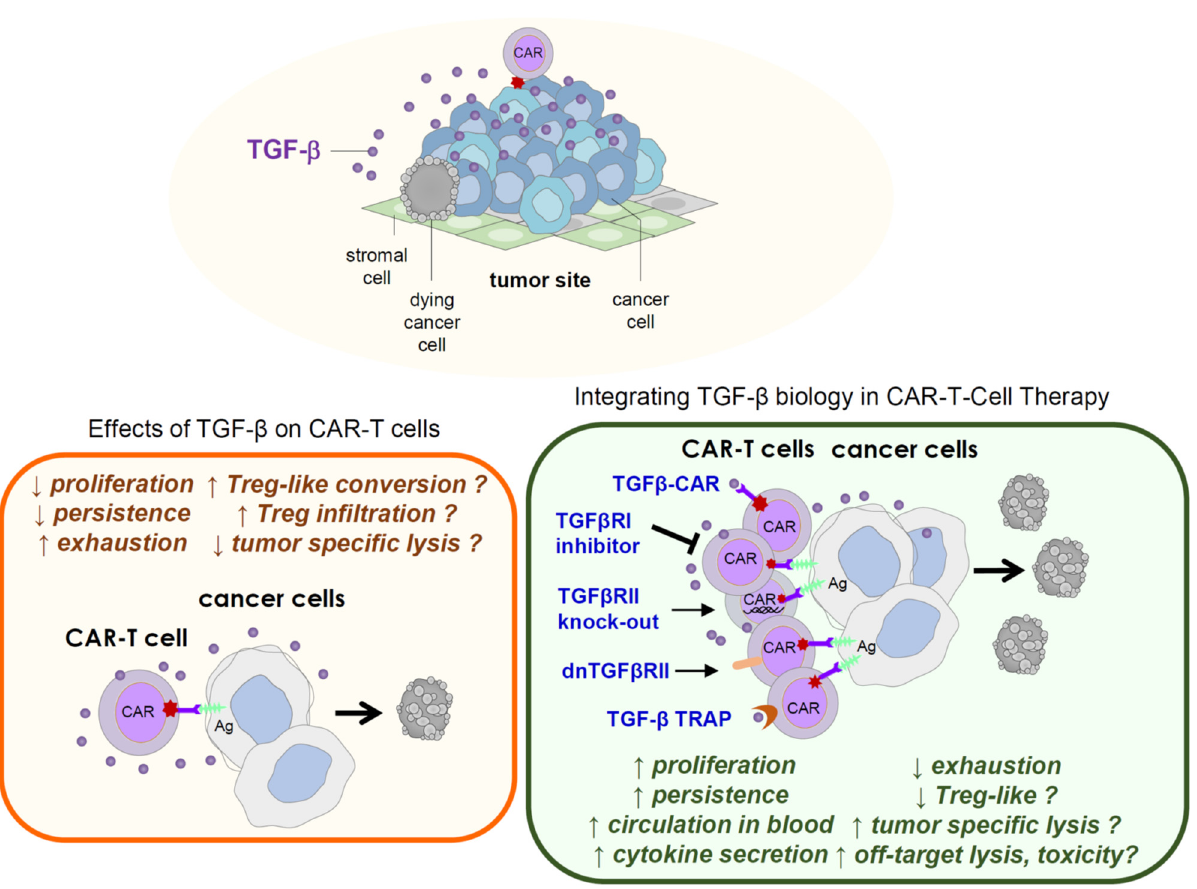
Figure 3. The effects of TGF- β on CAR-T cells and targeting of TGF- β to improve CAR-T cell therapy.